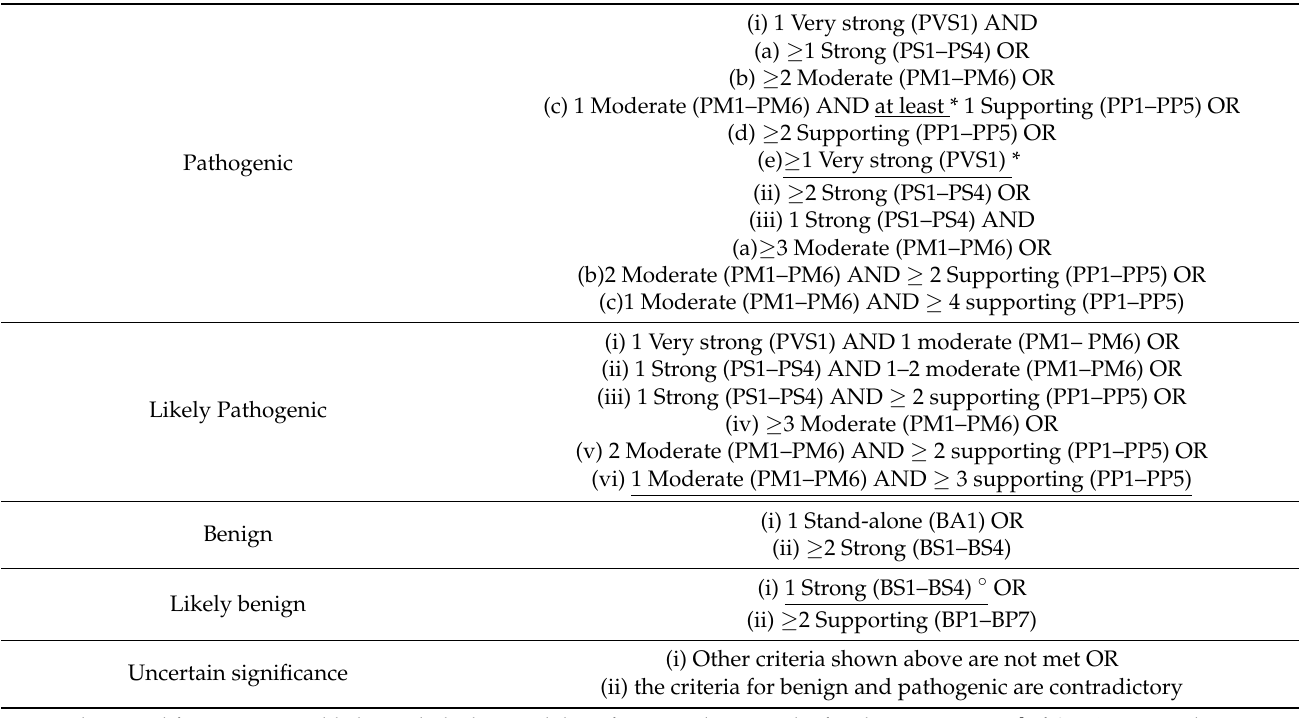
Table 1. Combination of criteria for variant interpretation according to ACMG-AMP guidelines. The modifications implemented in the internal ACMG-based classifier are underlined.